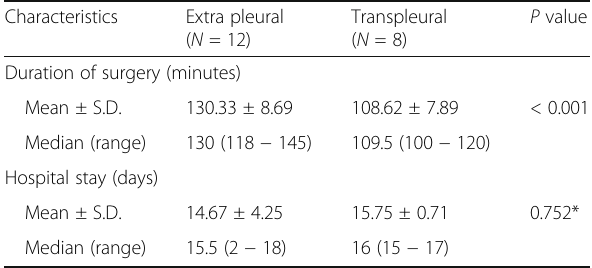
Table 3 Comparison between the studied groups regarding hospital stay and duration of